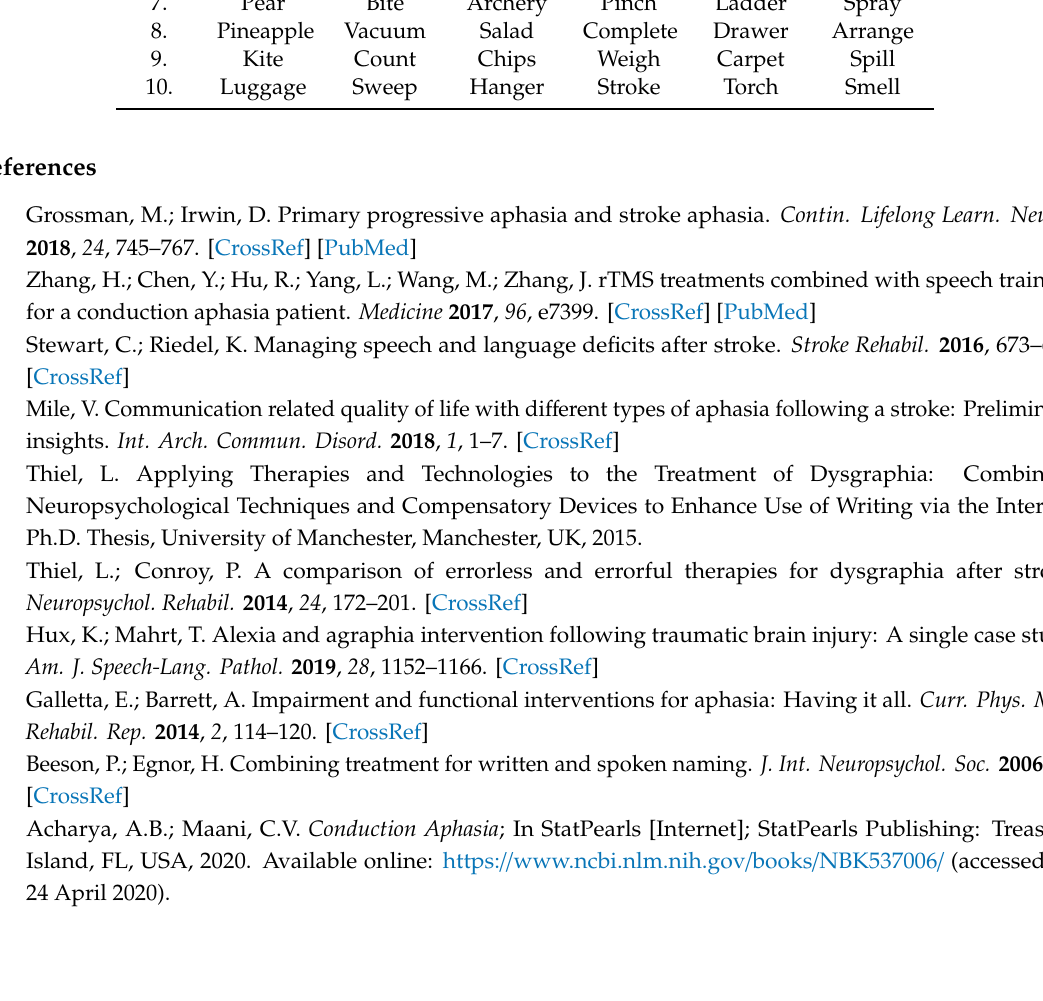
Table A1. List of trained words selected for the treatment of dysgraphia. Set 1 Set 2 Set 3 Nouns Verbs Nouns Verbs Nouns Verbs 1. Tissue Wrap Cabbage Type Fries Bake 2. Pizza Squeeze Globe Paste Squash Grate 3. Cricket Tear Gymnastic Swim Toaster Spread 4. Perfume Tickle Chocolate Shave Onion Hug 5. Dominos Yawn Dice Search Kettle Pray 6. Sandwich Break Purse Wave Fridge Tire 7. Pear Bite Archery Pinch Ladder Spray 8. Pineapple Vacuum Salad Complete Drawer Arrange 9. Kite Count Chips Weigh Carpet Spill 10. Luggage Sweep Hanger Stroke Torch